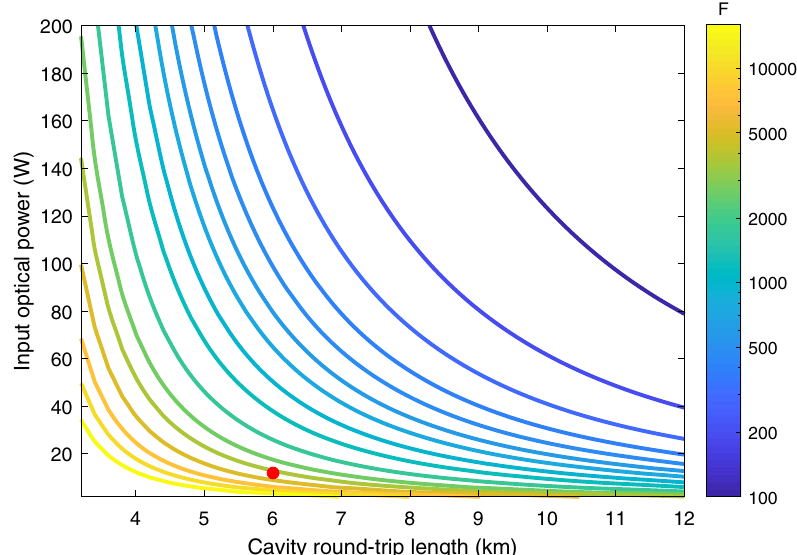
Fig. 3 Input power requirements. Required input optical power as a function of cavity round-trip length and fi nesse F . The cavity baseline is fi xed at 1 km, and the maximum pulse duration, minimizing power requirements, is selected. This is the limiting value for the pulses to avoid spatial overlap at the atoms; see Methods. The parameters used throughout are indicated by the red